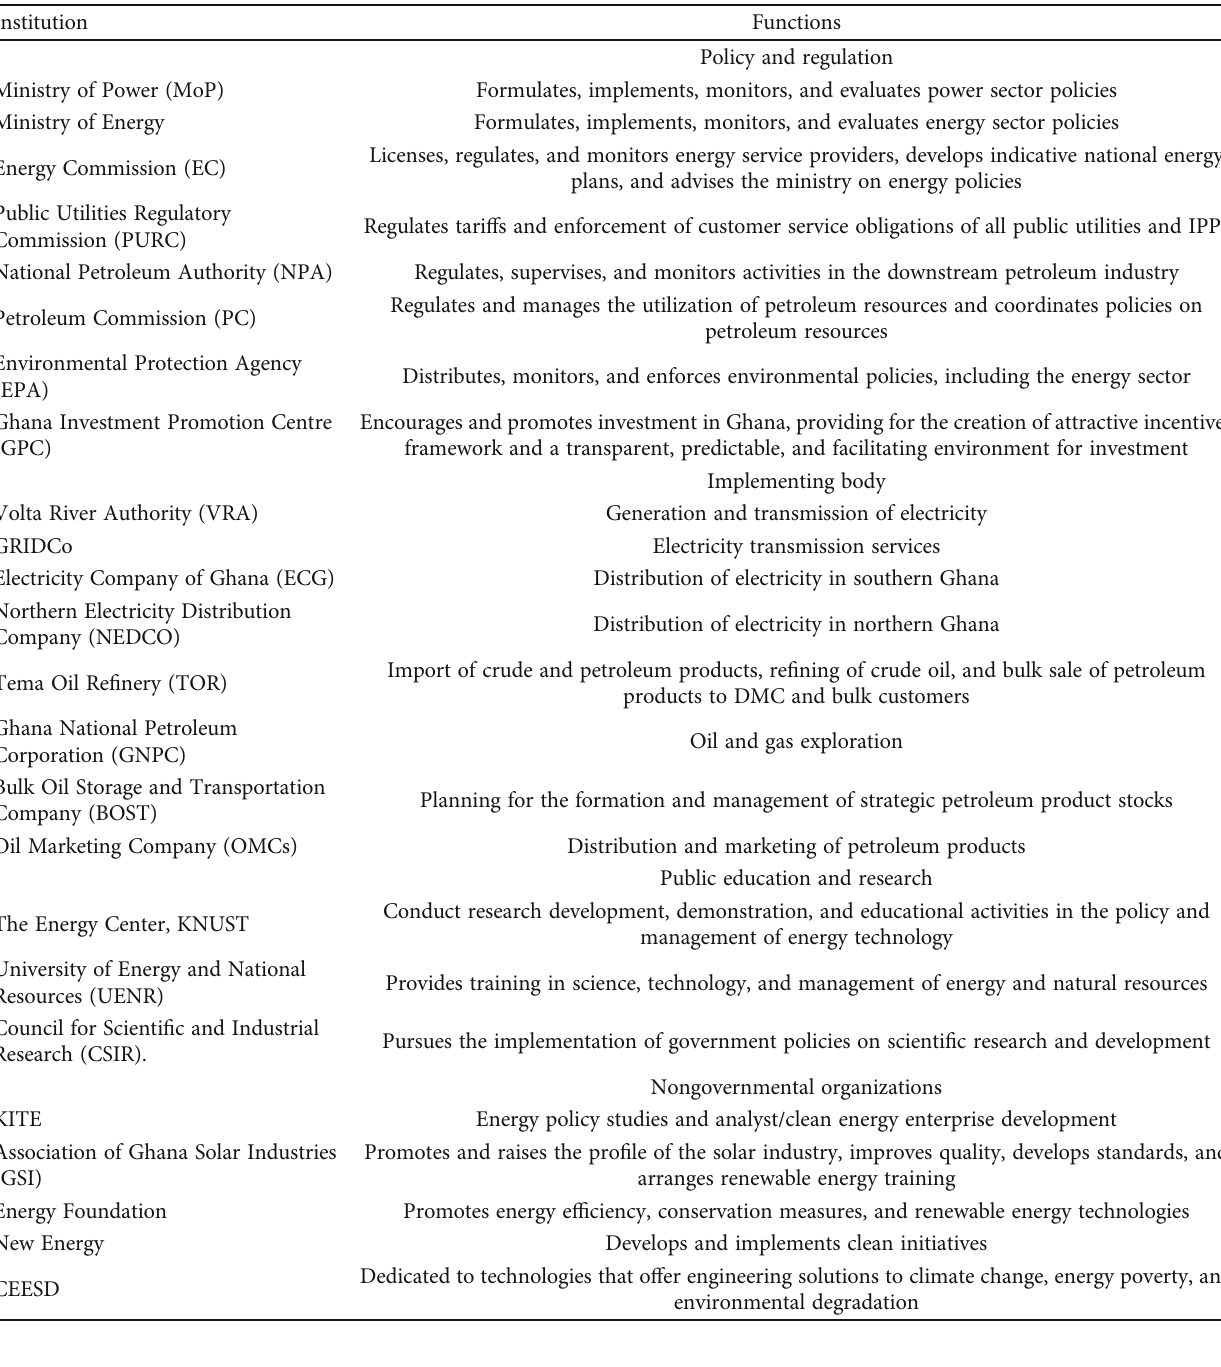
Table 1: Key institution in Ghana ’ s energy sector